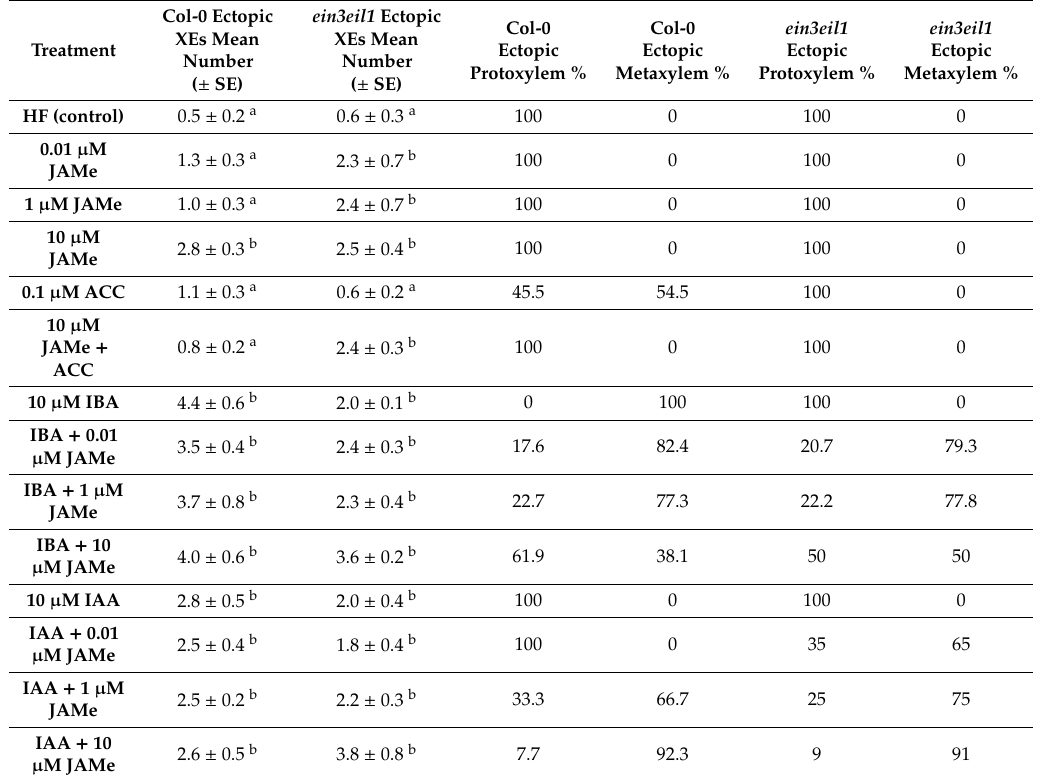
Table 1. Quantification of ectopic xylary elements (XEs) detected in the basal hypocotyl of Col-0 and ein3eil1 seedlings. Mean number ( ± standard error (SE)) of XEs and percentage of ectopic protoxylem and metaxylem elements detected in an area of 150 × 150 µ m 2 in the middle portion of the basal hypocotyl with di ff erent treatments. ACC, IBA and IAA were always used at 0.1 µ M, 10 µ M and 10 µ M, respectively. Di ff erent letters among values within the same column indicate significant di ff erences at least at p < 0.05. The same letter indicates no statistical di ff erence. One-way ANOVA followed by Tukey’s post-test. n =